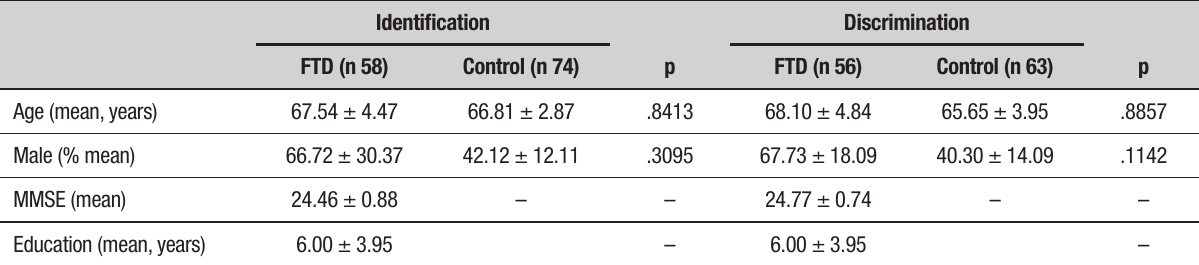
Table 3. Comparison between behavioral variant